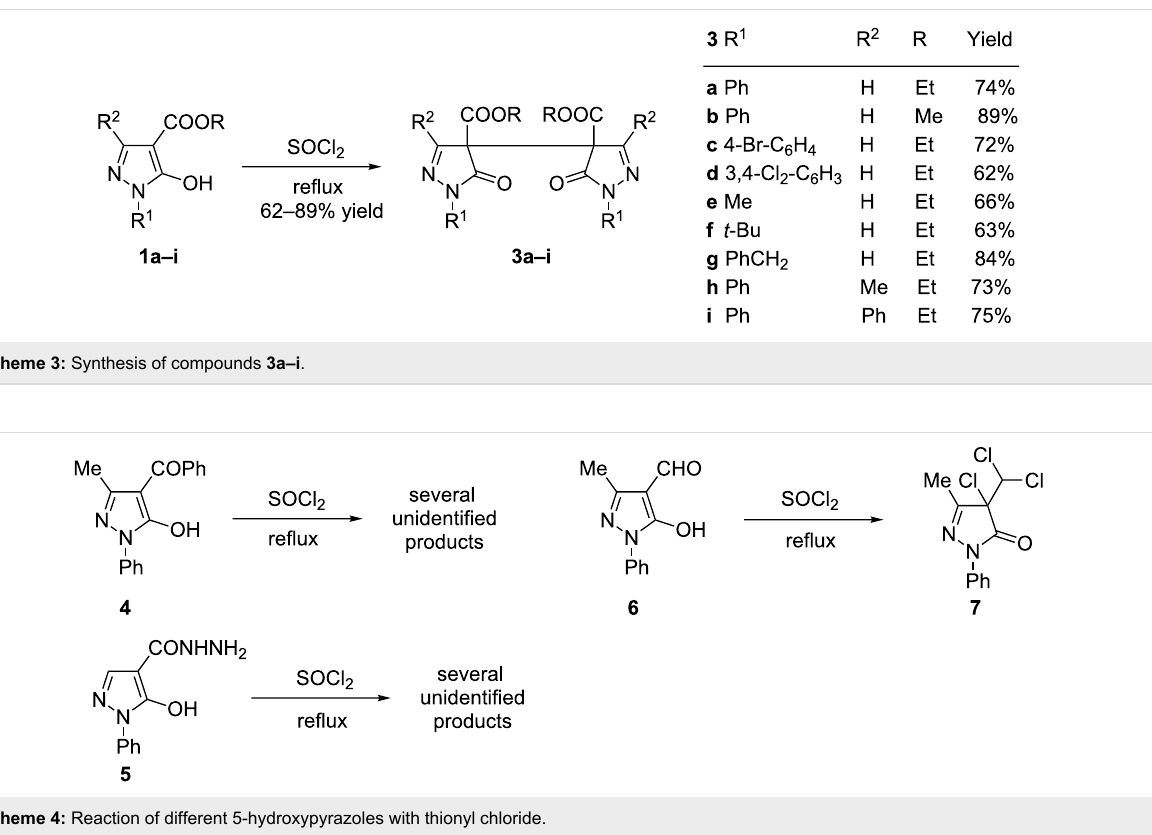
were subjected to the same reaction conditions (refluxing